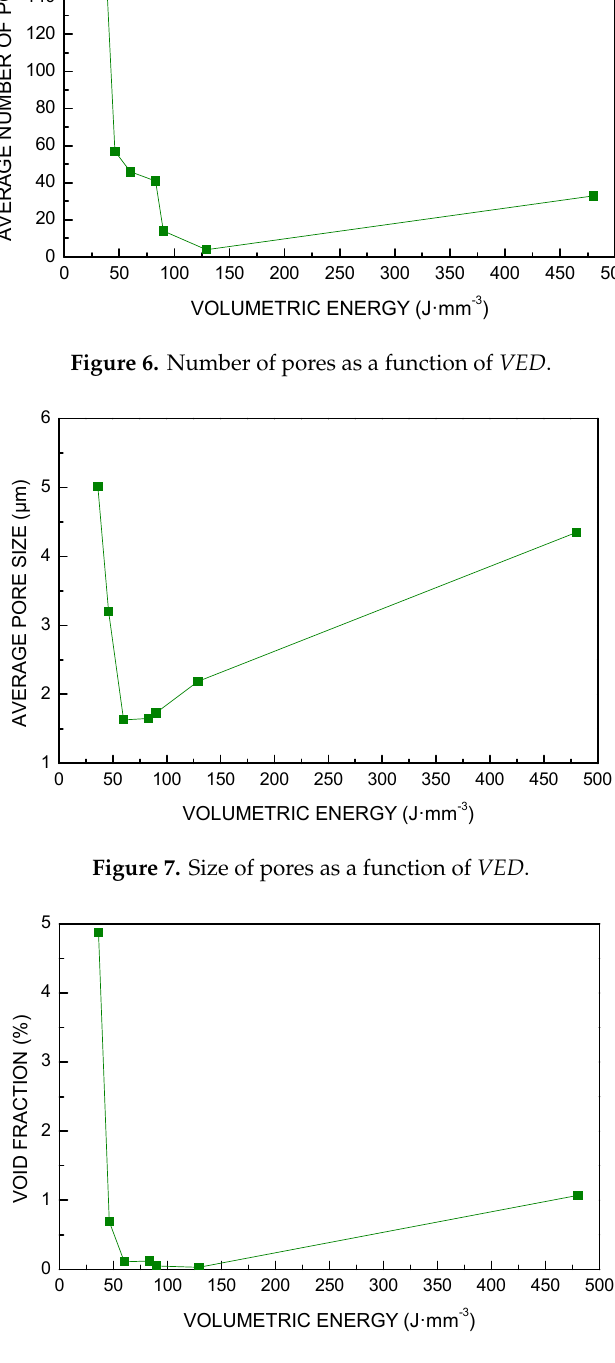
Figure 8. Void fraction as a function of VED .